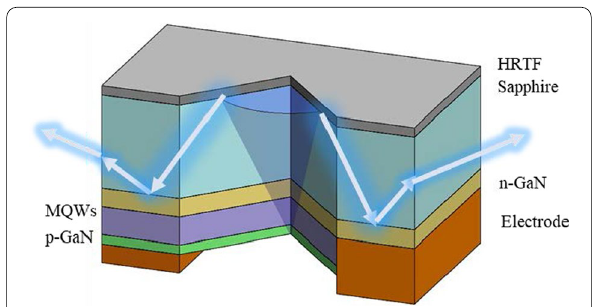
Fig. 2 The light path within the full‑angle micro‑LEDs with HRTF coating